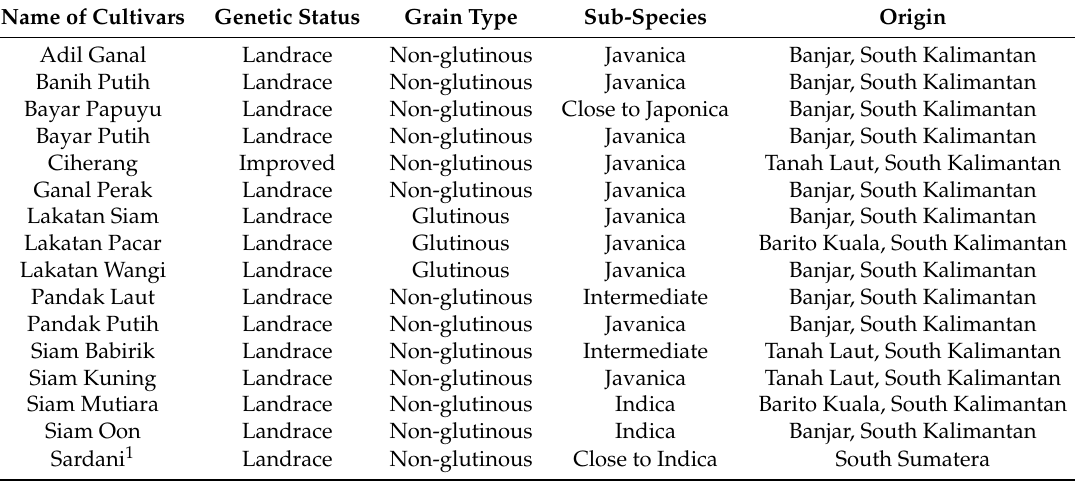
Table 1. List of the tidal swamp rice employed in this study.